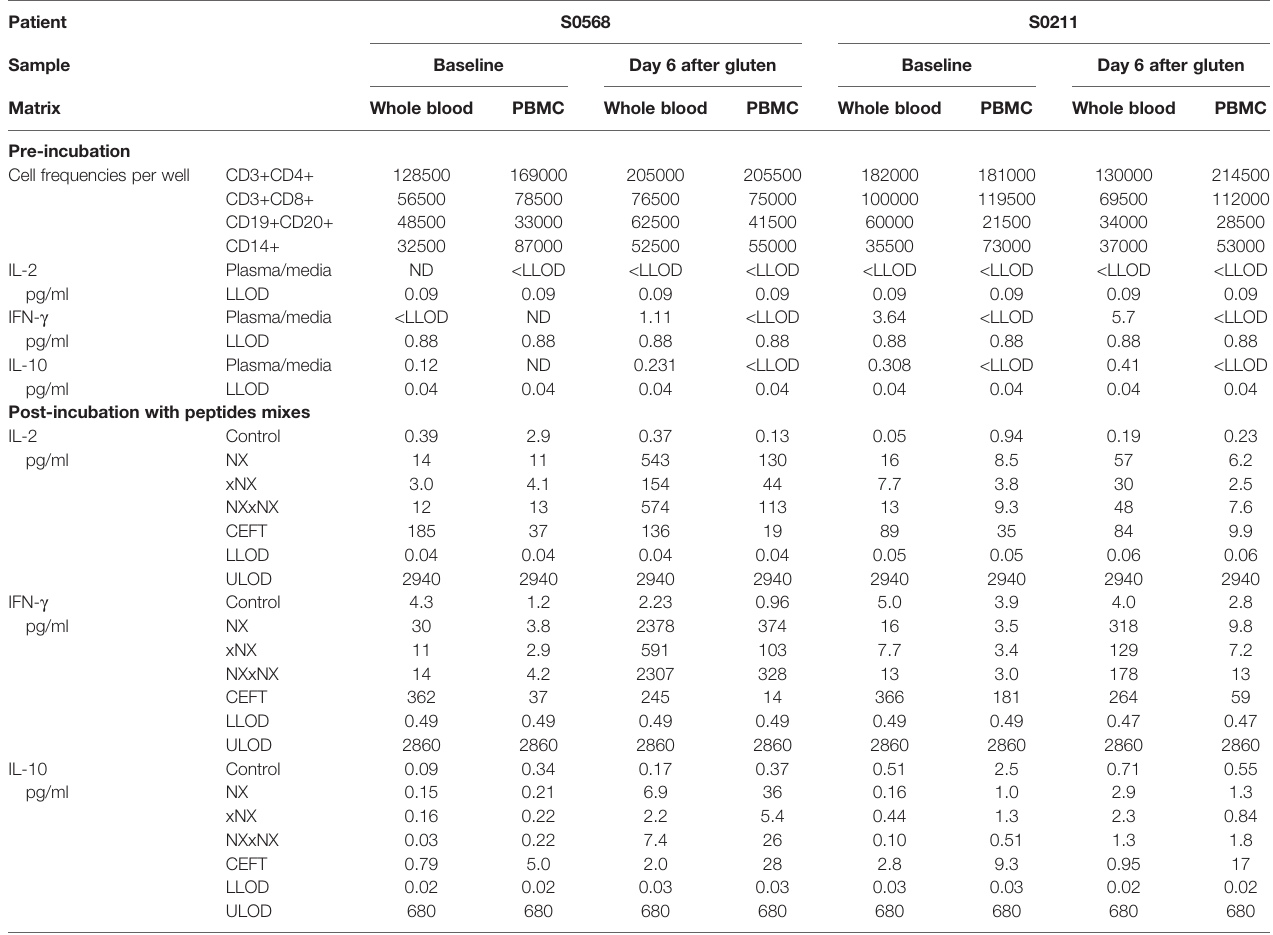
TABLE 2 | Cytokine concentrations in plasma or media release